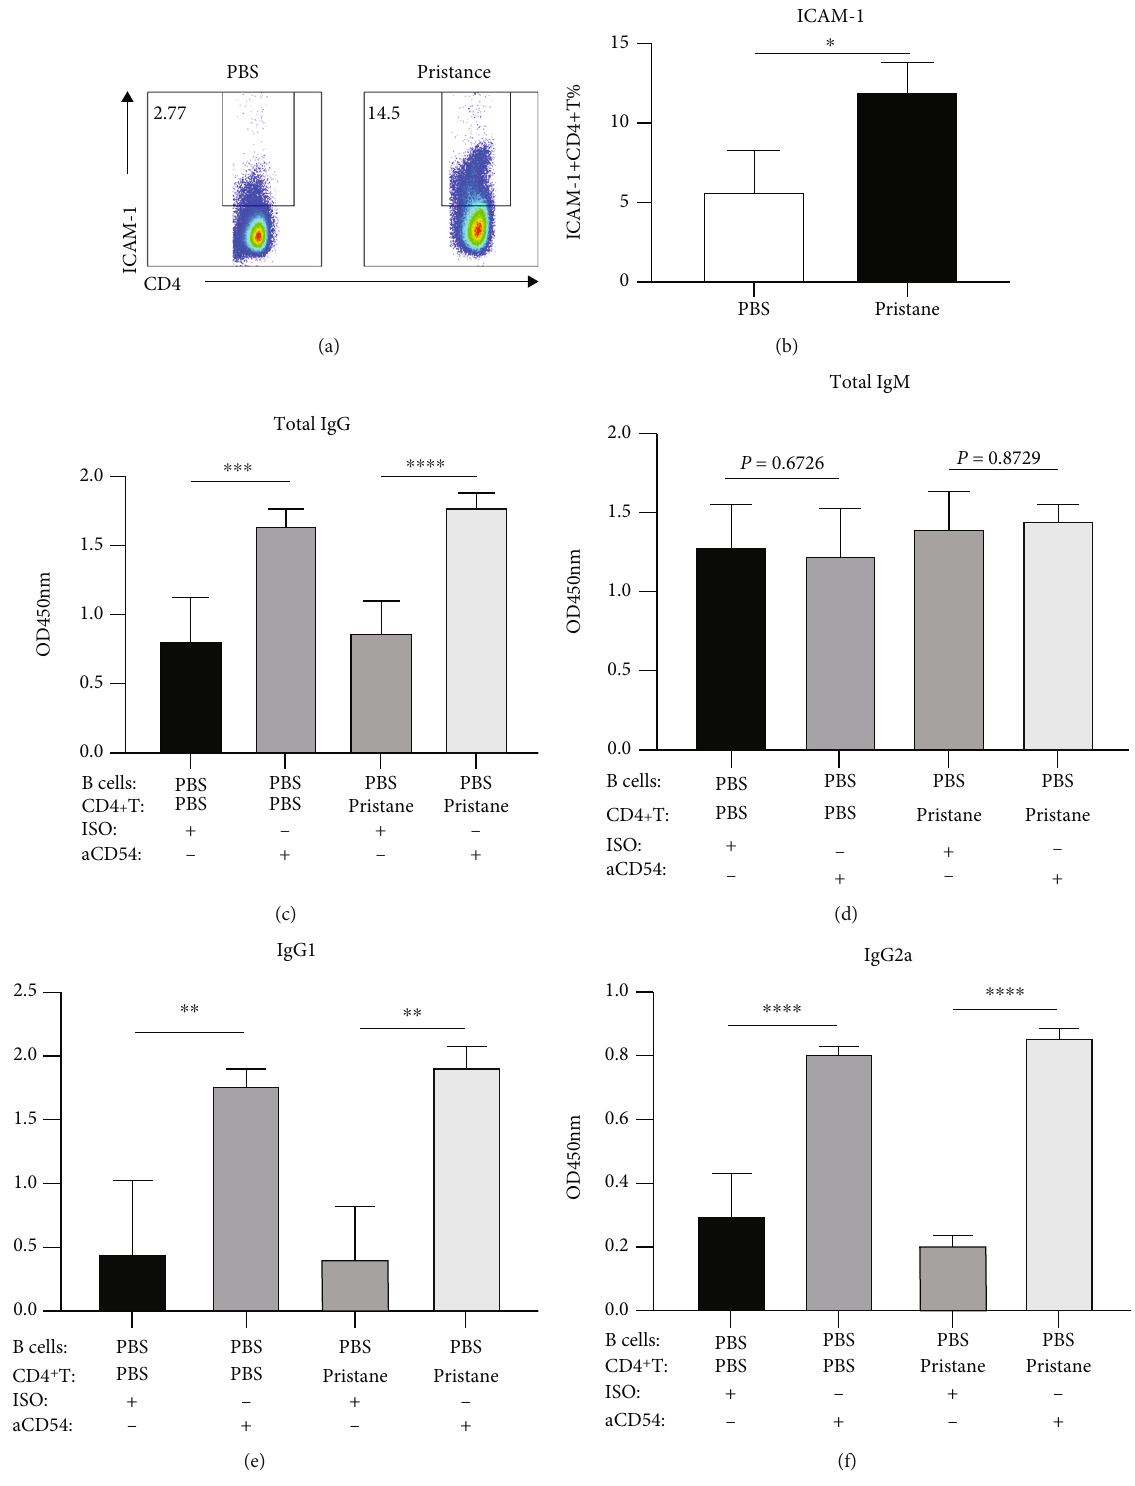
Figure 5: ICAM-1 attenuates IgG production in the coculture of CD4 + T cell and B cell interaction from PBS or pristane-treated mice. CD4 + T cells and B cells were sorted from PBS and pristane-treated BALB/c mouse (6 months later) by MACS, respectively. 3 × 10 4 CD4 + T cells were cultured with 9 × 10 4 B cells derived from PBS or pristane mice (on a BALB/c background). (a) Flow cytometric analysis of ICAM-1 expression on CD4 + T cells. (b) Increased expression levels of ICAM-1 on CD4 + T cells from lupus-like mice. (c – f) Total IgG (c), IgM (d), IgG1 (e), and IgG2a (f) levels in the supernatants of di ff erent coculture groups (T+B, T+B+ISO, and T+B+anti-ICAM-1) were quanti fi ed by the ELISA assays. Each group had at least fi ve mice for the analysis. Data are represented by mean of OD mice. ∗ p < 0 : 05 ; ∗∗ p < 0 : 01 ; ∗∗∗ p < 0 : 001 ; ∗∗∗∗ p < 0 : 0001